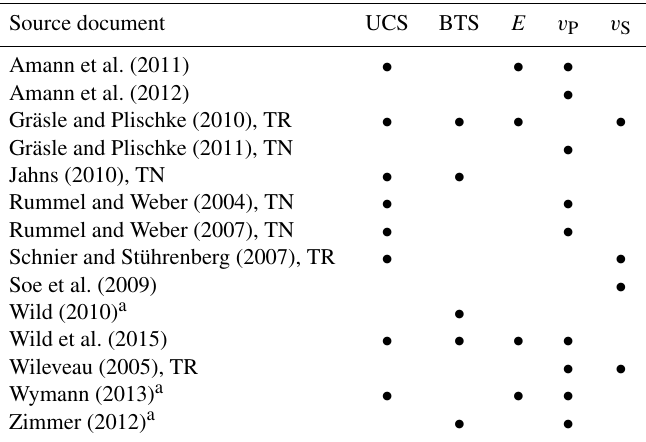
Table A1. Source documents for experimental data on uniaxial compressive strength (UCS), Brazilian tensile strength (BTS), Young’s modulus ( E ), and elastic P-wave ( v P ) and S-wave velocity ( v S ) of the Opalinus Clay (shaly facies) in Mont